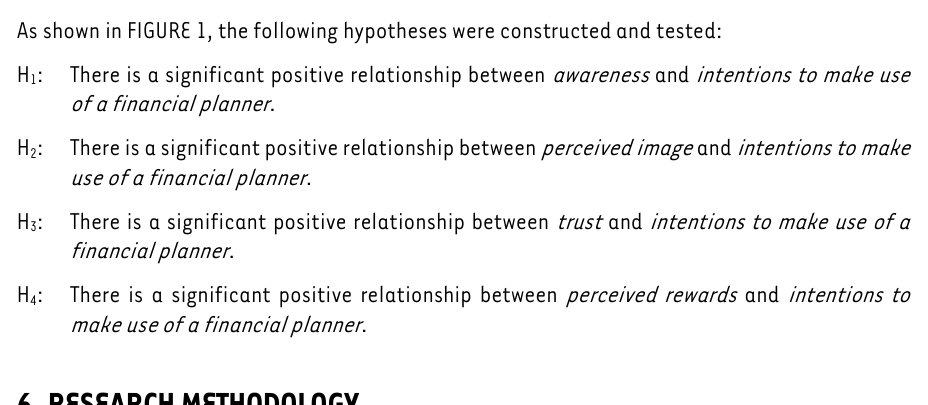
FIGURE 1: Hypothesised model Source: Authors’